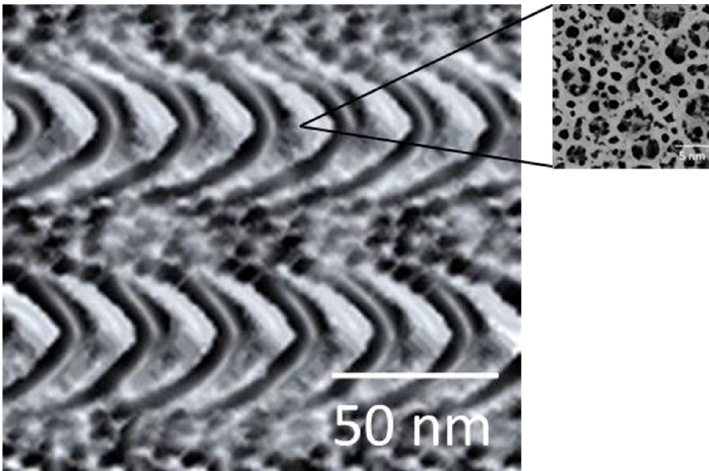
Figure 3. TEM image of TiO 2 scaffolds.